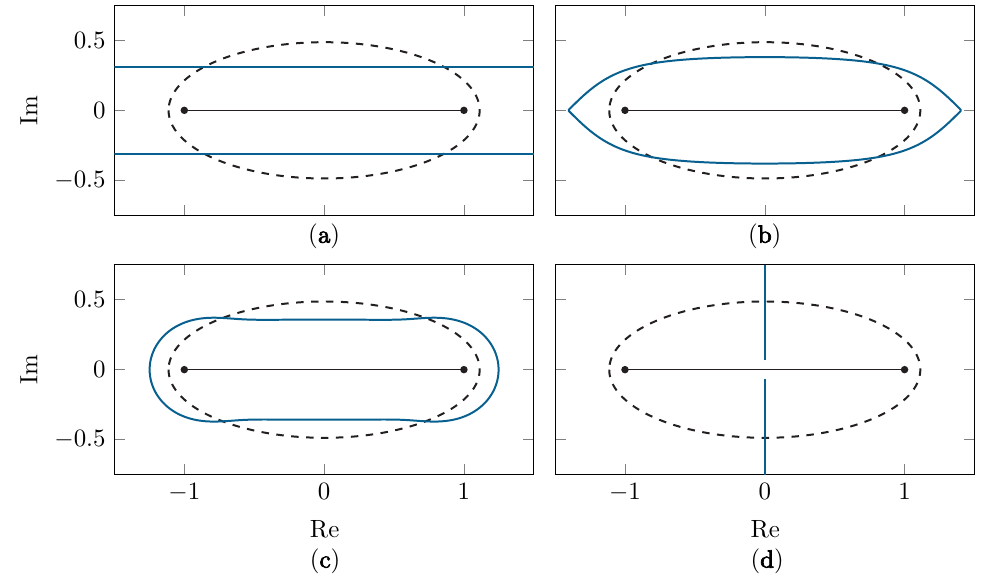
Figure 2. The E 1.6 Bernstein ellipse (dashed black line) and its image (solid blue line) under the Ellipse-to-Strip map ( a ), the KTE map ( b ), the Sausage map ( c ) and the Ellipse-to-Slit map with slits along the imaginary axis ( d